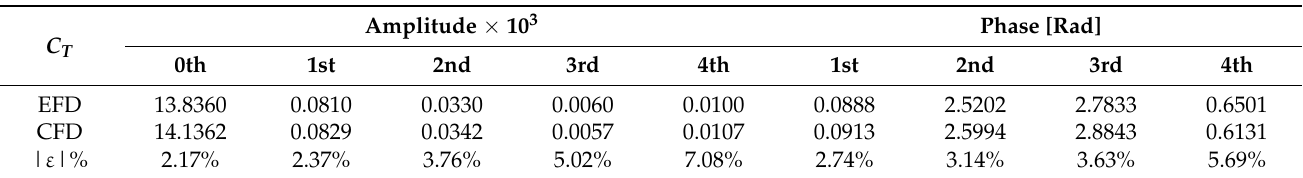
Table 4. Harmonic amplitudes and phases of the total resistance coefficient ( C T ) for the FRxz ϕθ head waves scenario. Table 5. Harmonic amplitudes and phases of surge (𝑥) for the 𝐹𝑅𝑥𝑧𝜑𝜃 head waves scenario.